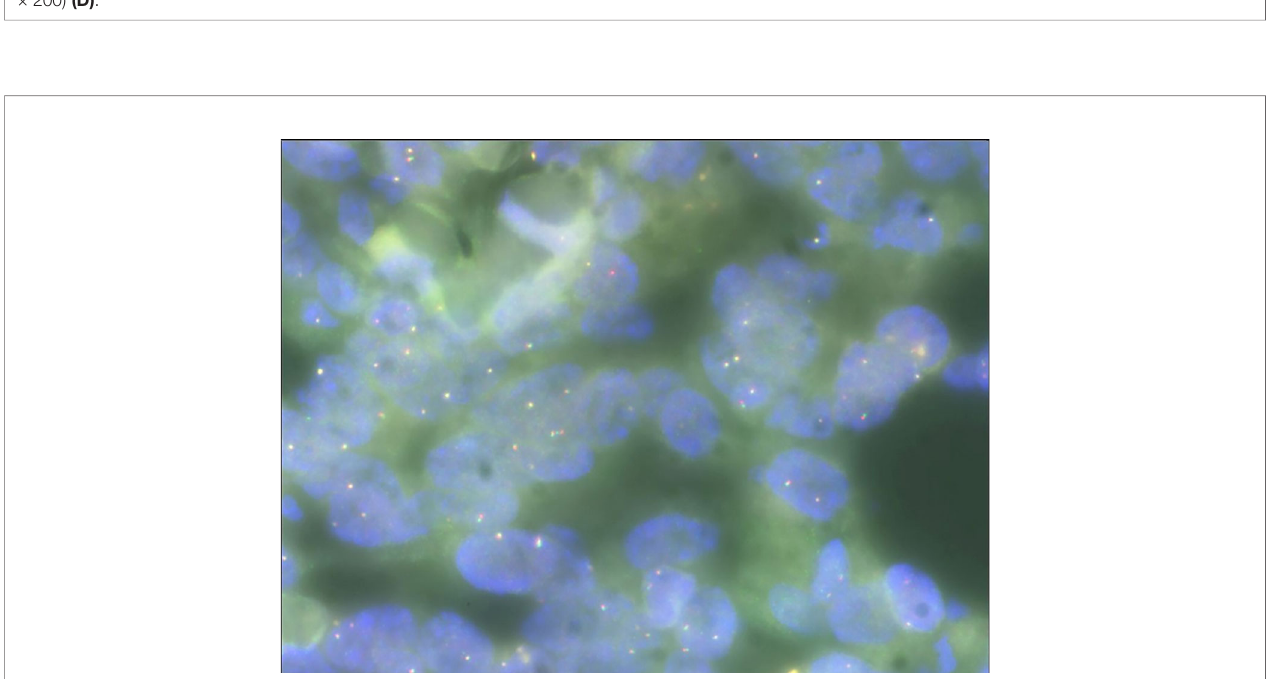
FIGURE 5 | Fluorescence in situ hybridization analysis showing no ALK gene rearrangement (× 100).